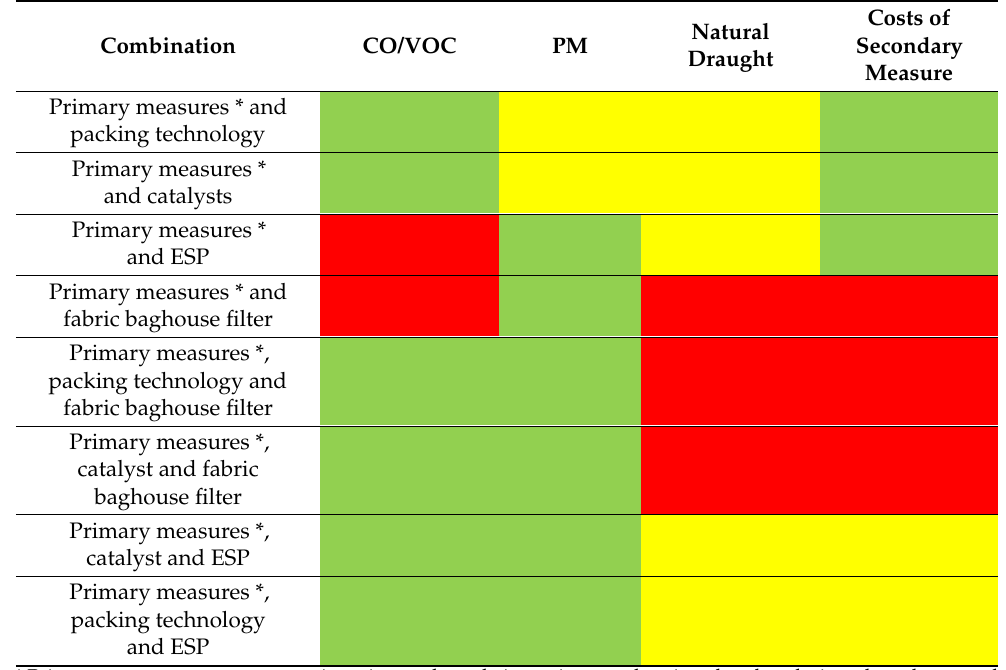
Table 9. Qualitative evaluation of potential combinations of primary measures and secondary technologies (red: negative; green: positive; yellow: